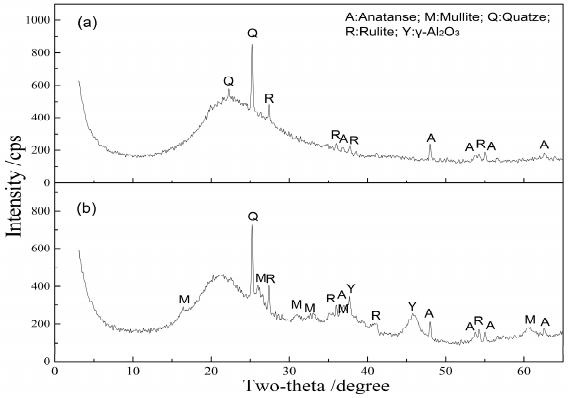
Figure 3. XRD patterns of kaolinite activated at 900 °C for 15 min ( a ) and at 1150 °C for 15 min ( b ).